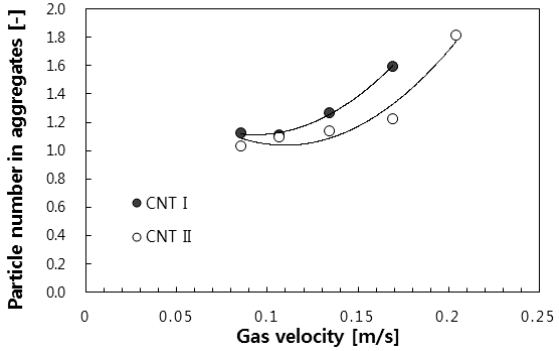
Figure 9. Effect of gas velocity on number of CNT particles in aggregates.